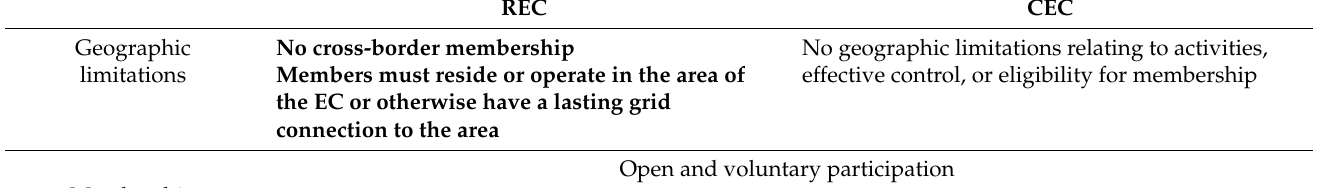
Table 3. The proposed Swedish law; boldface text indicates a change, adjustment, or specification compared with the CEP. REC CEC